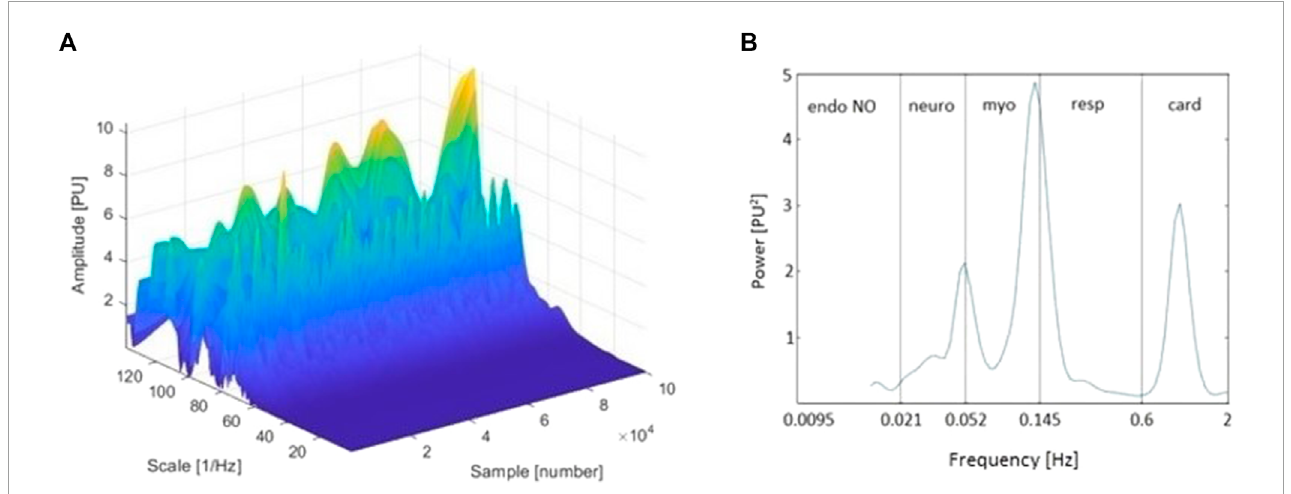
FIGURE 1 (A) Three-dimensional wavelet transform (WT) of the laser Doppler (LD) signal of a representative tracing (baseline period, finger pulp); and (B) Time-averaged wavelet power spectrum of the same signal and frequency intervals corresponding to endothelial nitric oxide (NO)-dependent (endo NO), neurogenic (neuro), myogenic (myo), respiratory (resp), and cardiac (card) physiological influences. The sample axis on the three-dimensional spectrum represents the sampling points of the signal. Thereby, it can also be observed as a time axis (A) .